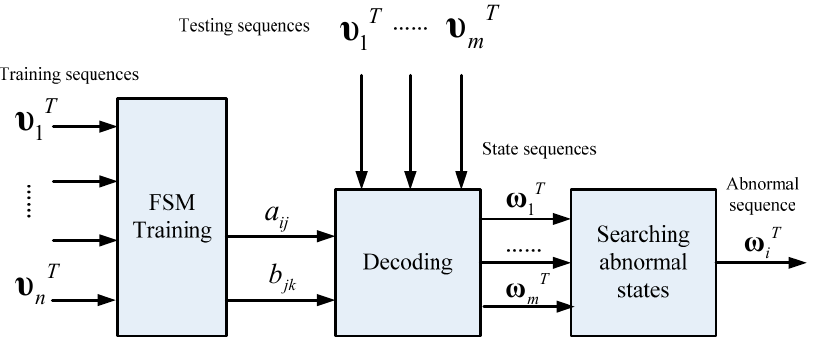
Figure 11. Schematic of anomaly detection using the decoding strategy.